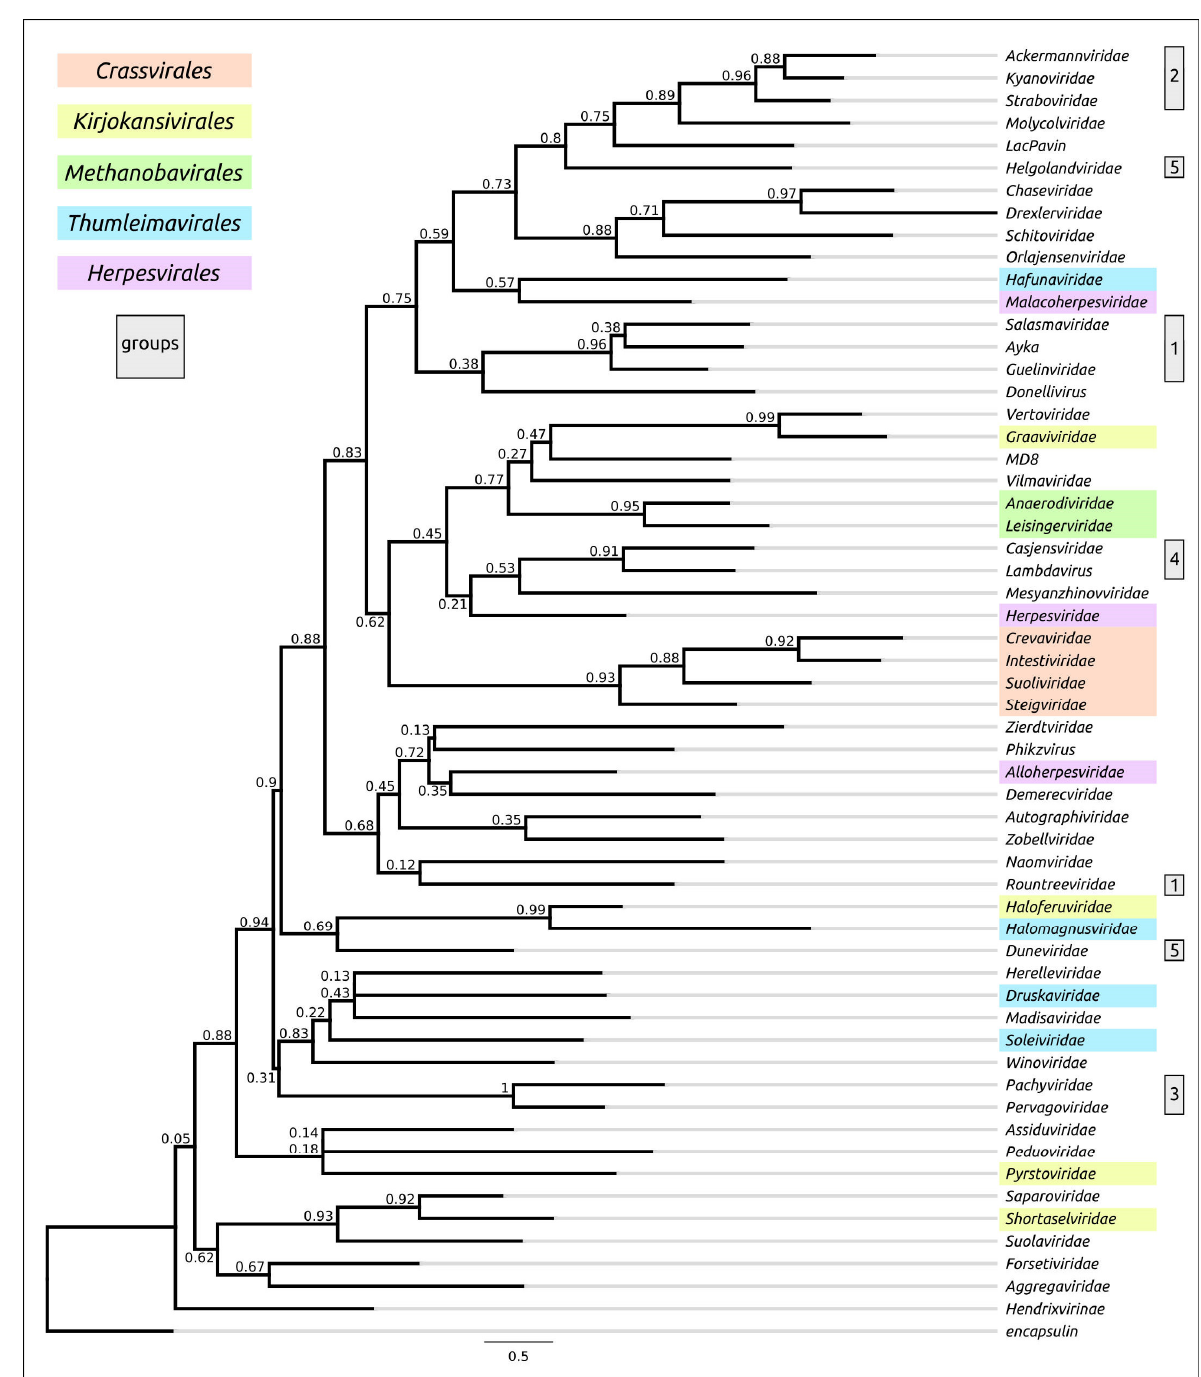
Figure 10. Best-scoring ML phylogenetic tree constructed with 57 amino acid sequences of major capsid protein and an encapsulin aligned with Clustal Omega. The scale bar shows 0.5 estimated substitutions per site and the trees were rooted to encapsulin.